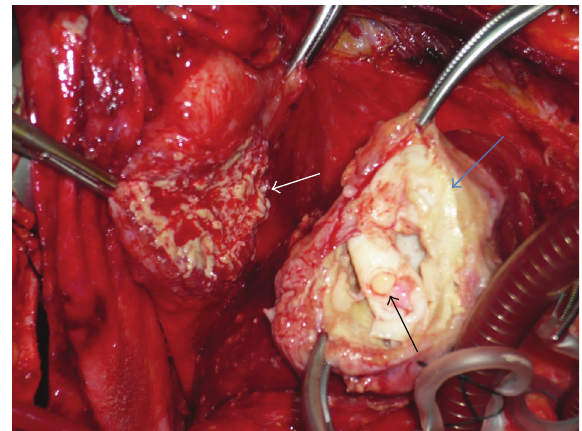
Figure 1: Preoperative teleradiography with apicolateral hydatid cyst image.